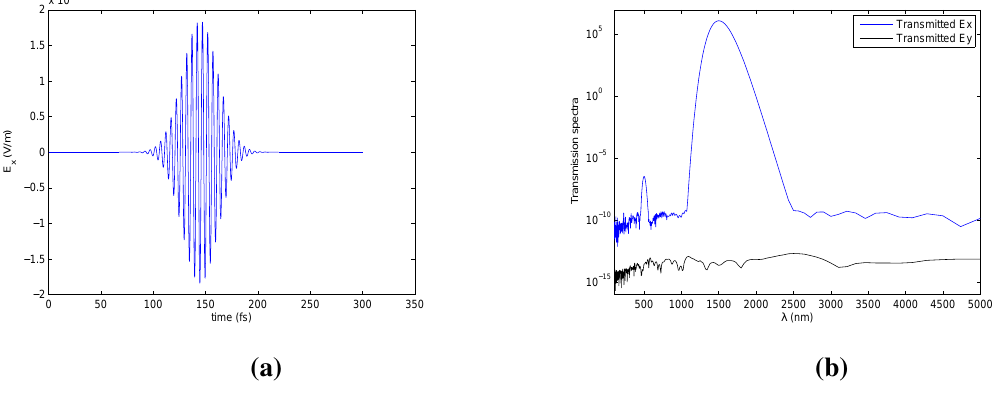
( a) Time history of the linear response for rectangular shaped nanoparticle illuminated by a x -polarized incident light; ( b ) Semi-log plot of the Fourier transform of the time history of the far-field projection of the E as functions of the wavelength.